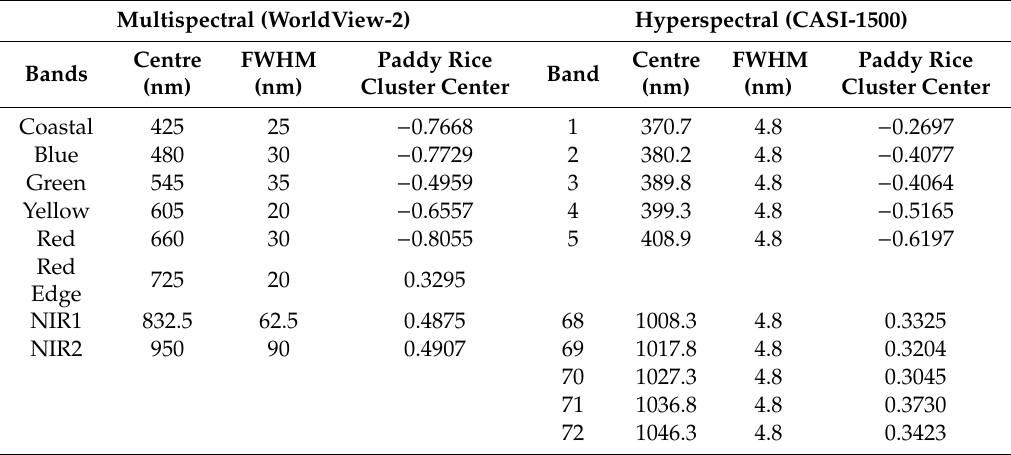
Table 1. The full width at half maximum (FWHM) of each band and the best accuracy of the clustering center of multispectral (8 bands) and the hyperspectral